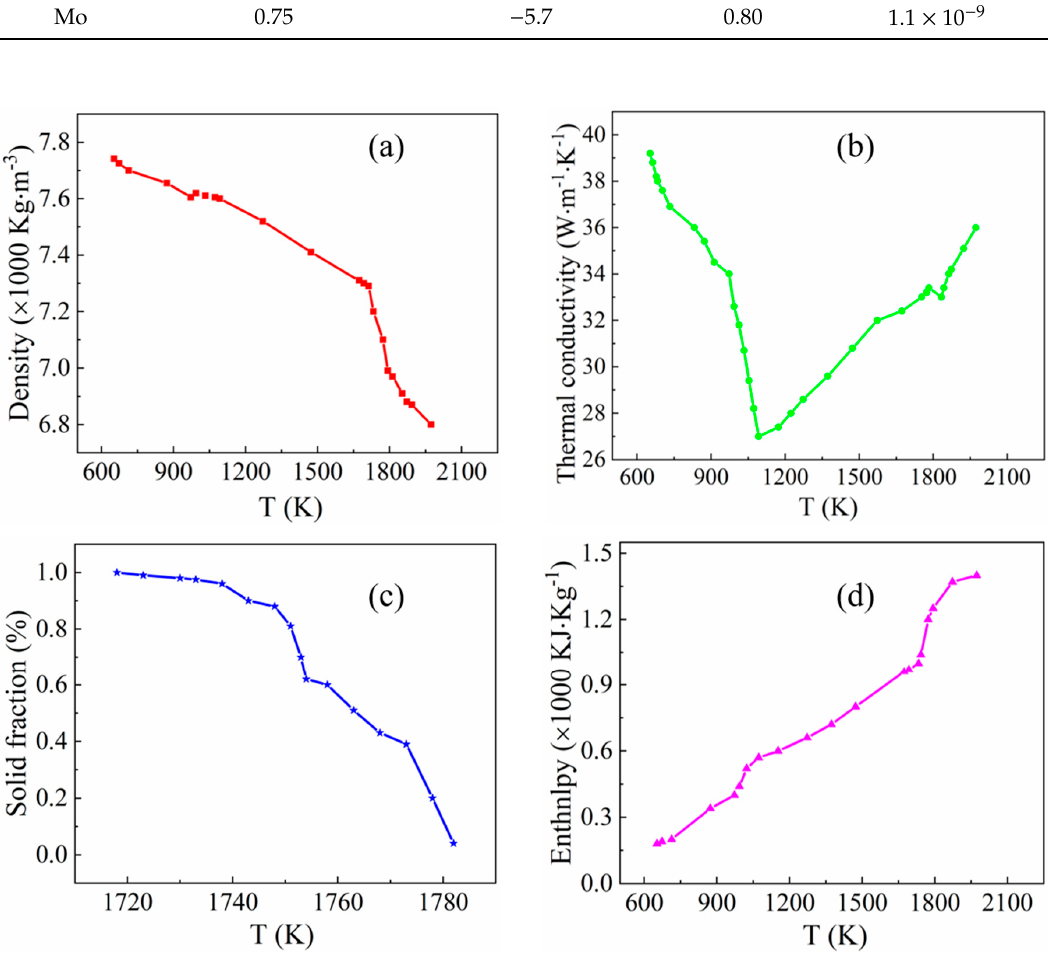
Figure 2. Changes in ( a ) density, ( b ) thermal conductivity, ( c ) solid fraction, and ( d ) enthalpy of the 26CrMoVTiB steel with temperature.